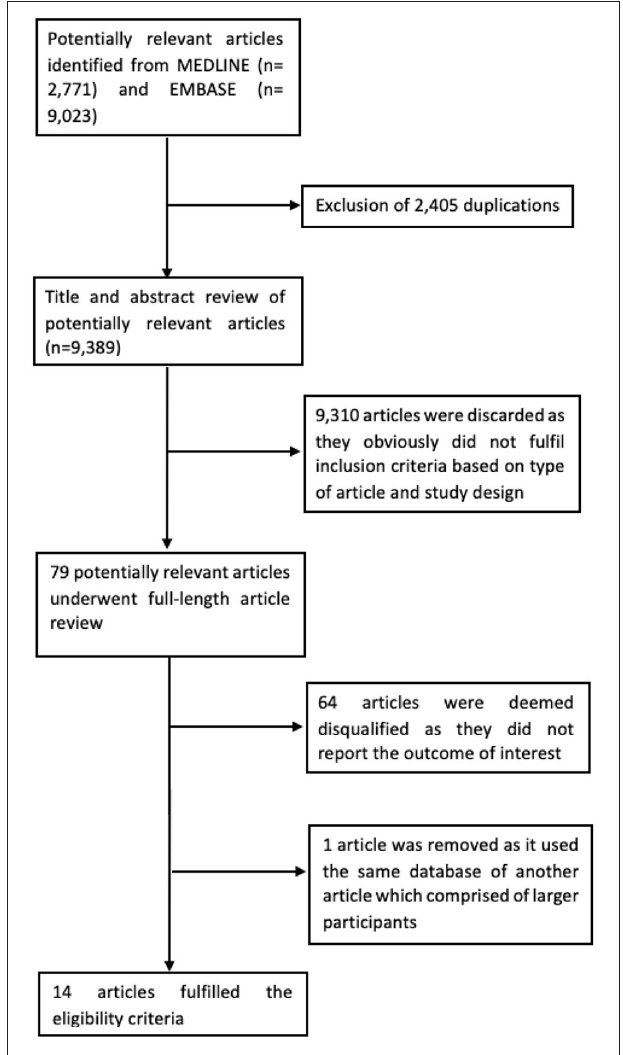
FIGURE 1 | Flowchart of literature review and study